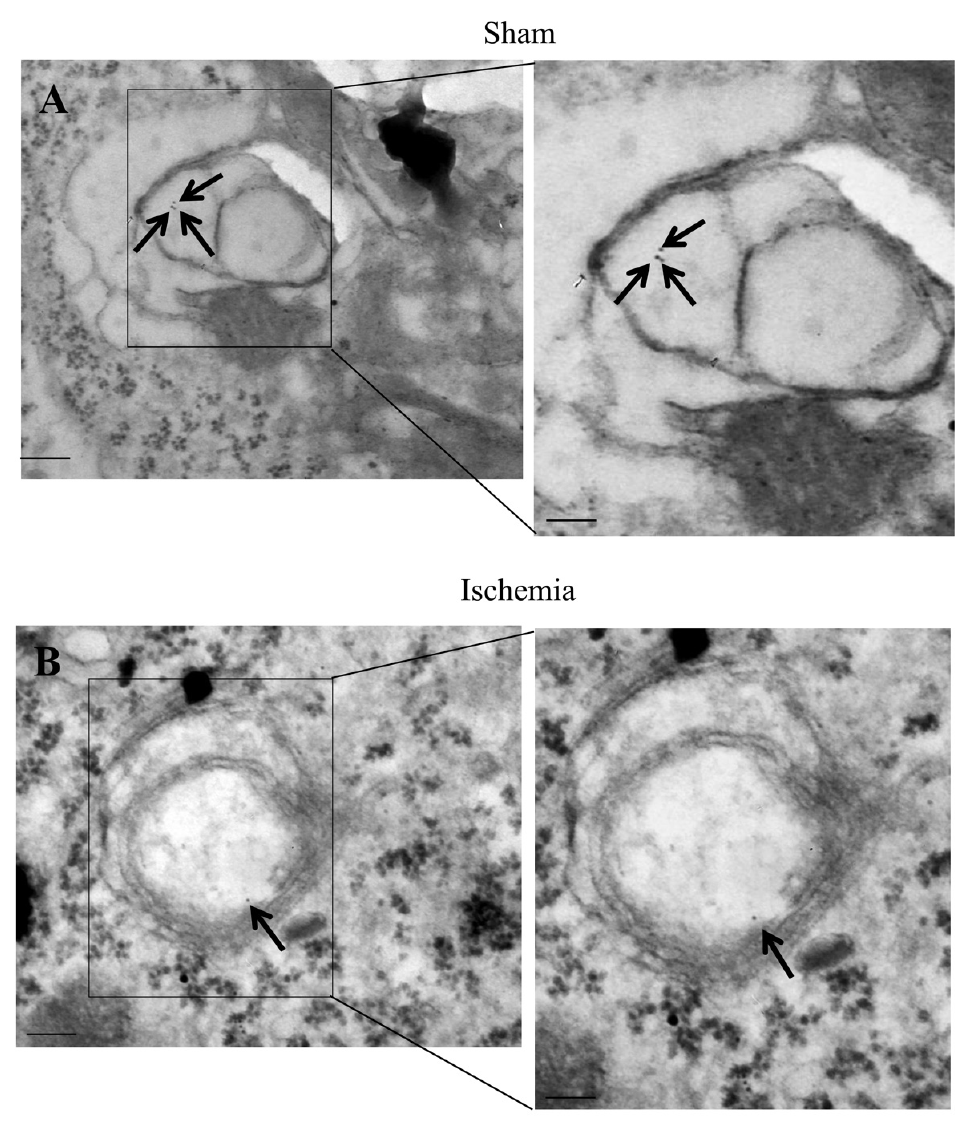
Figure 10. P20S within area penumbra . Representative TEM micrographs showing P20S-positive vacuoles within an allo-cortical neuron from a ventral region homologous to area penumbra from a sham mouse (Sham, A ) and an allo-cortical neuron from ventral area penumbra from an ischemic mouse (Ischemia, B ). Arrows point to P20S immuno-gold particles (10 nm) within vacuoles. The insert highlights the immuno-gold particles within vacuoles. Scale bar = 0.2 μ m ( A , B ), 0.1 μ m (in- serts).